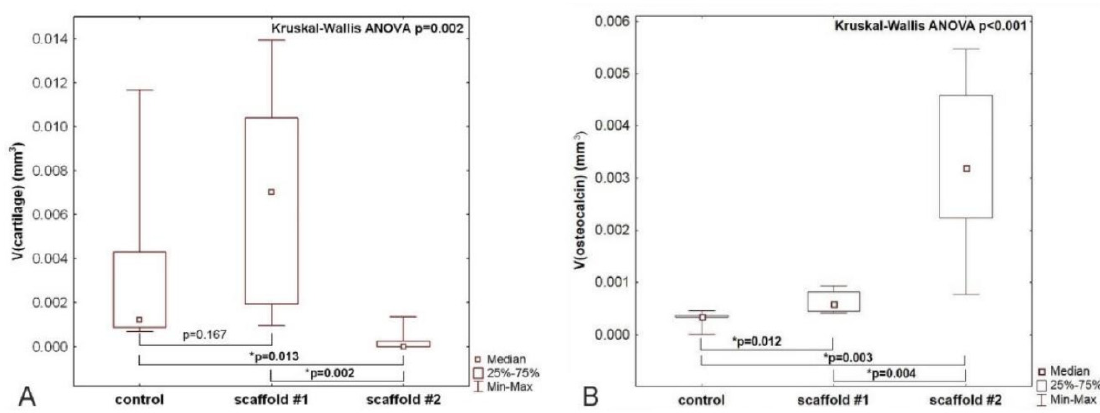
Figure 6. The volume of the newly formed hyaline cartilage ( A ) and osteocalcin-positive osteoblasts and bone matrix ( B ) within the center of the defect. A—The volume of the cartilage was greater in the sca ff old #1 group (PCL-chit-PEGb MPs mixed with collagen / fibrin / PRP gel) than in the sca ff old #2 group (PCL-chit-PEGb-antiCD44 MPs mixed with collagen / fibrin / PRP gel) (Mann–Whitney U test p = 0.002). The volume of cartilage was comparable in the sca ff old #1 group and in the control group (untreated) and smaller in the sca ff old #2 group than in the control group ( p = 0.013). B—The volume of the osteocalcin-positive elements was greater in both the sca ff old #1 ( p = 0.012) and sca ff old #2 ( p = 0.003) groups when compared with the control group. The volume of osteocalcin-positive elements was greater in the sca ff old #2 group than in the sca ff old #1 group ( p =